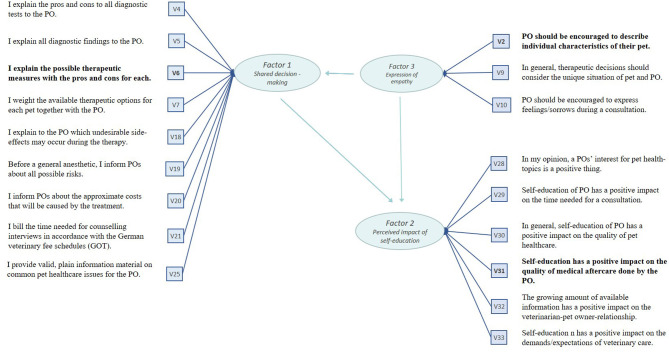
Measurement model to evaluate associations between German veterinarian's information preferences and their perceived impact of pet owner's self-education. Model assumptions based on results of Exploratory Factor Analysis. Factor labels reflect the hypothesized underlying latent construct measured by the questionnaire items. PO = power owner; V = measurement item; bold font = measurement items with highest value of standardized regression coefficient. Calculation dine with SAS version 9.4, N = 262.